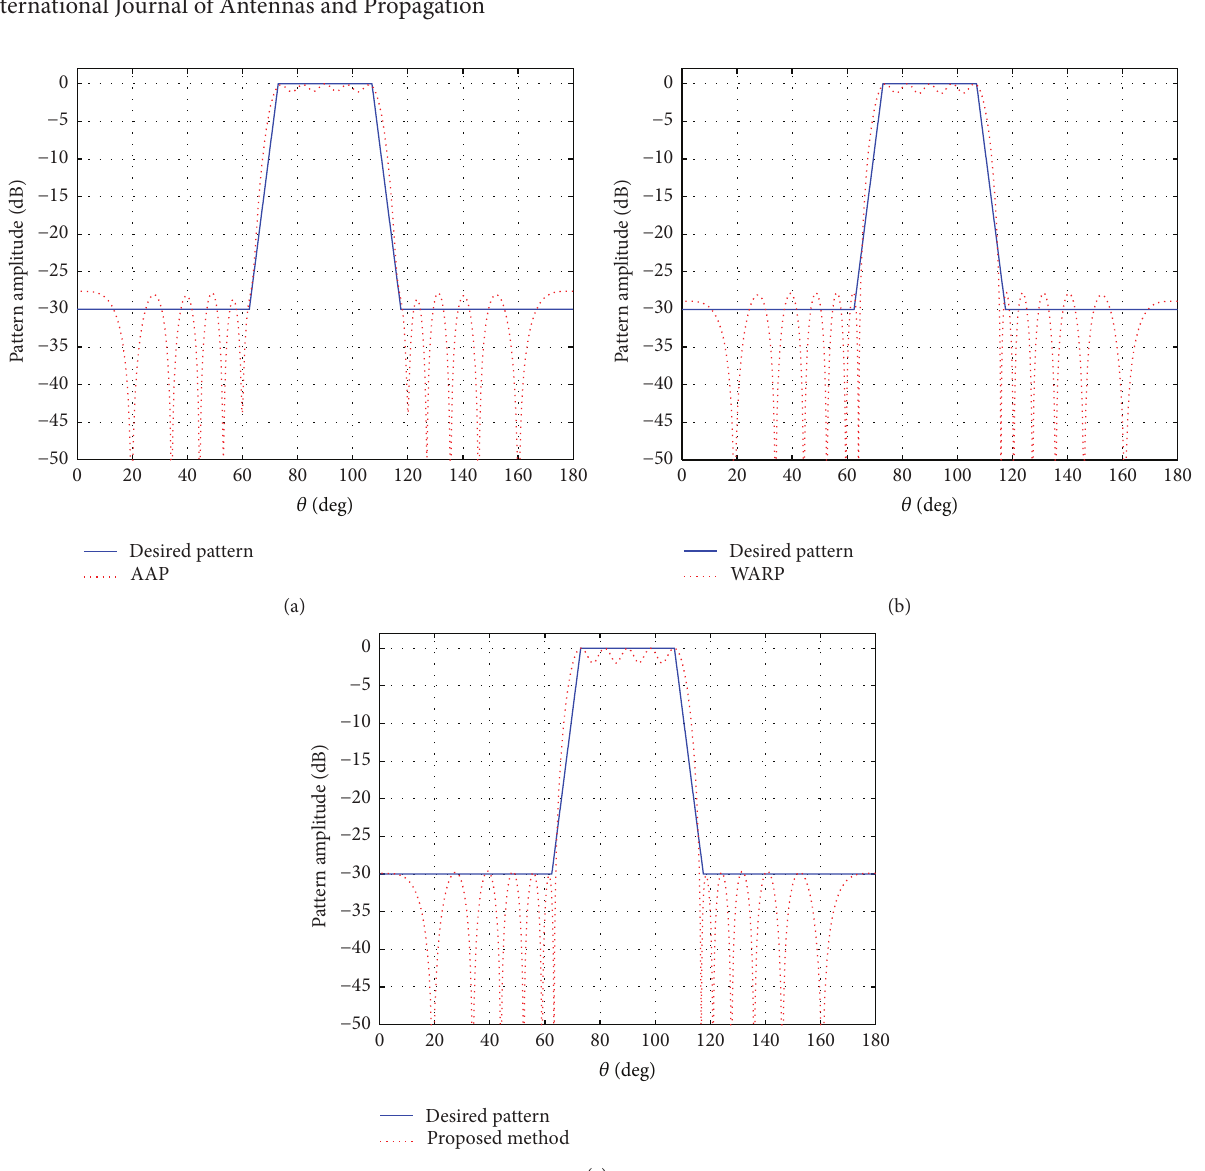
Algorithm 3 (scalable array synthesis using weighted alternat- ing projection and proximal